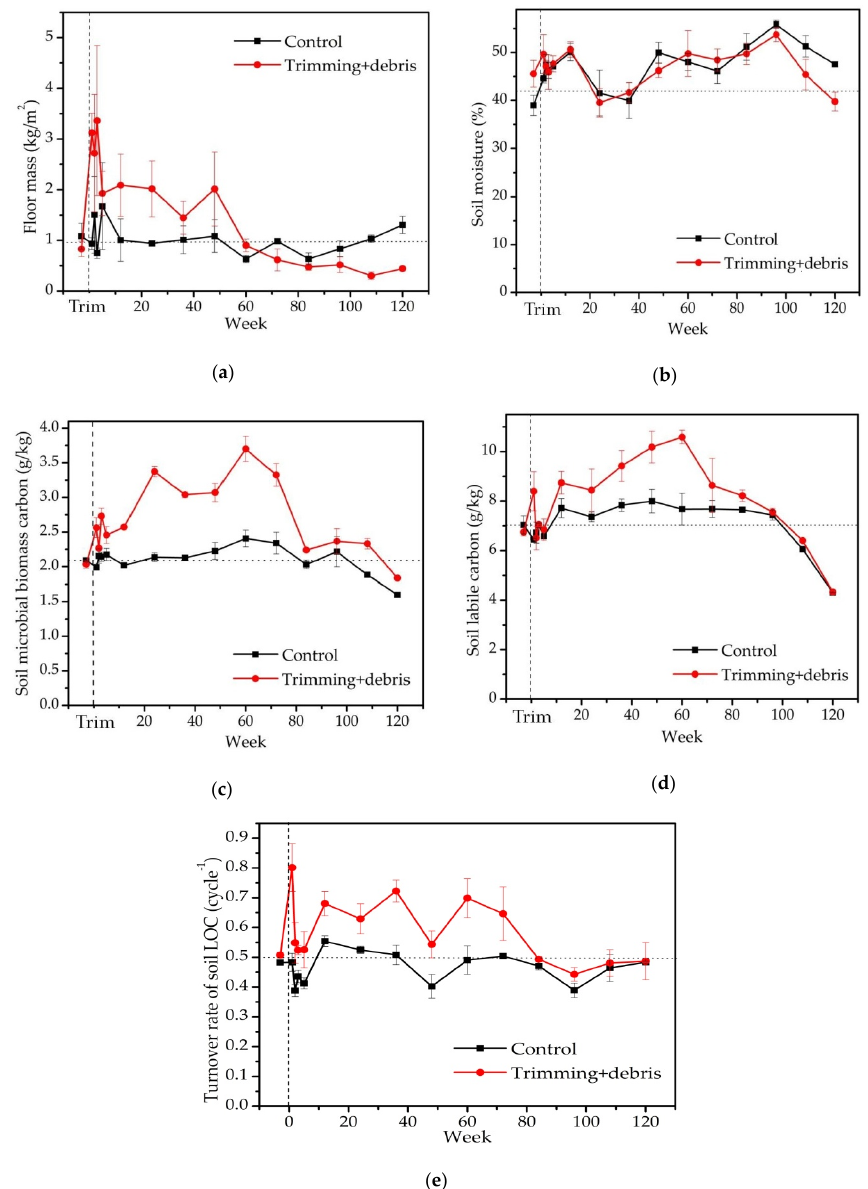
Figure 2. Dynamics of ( a ) floor mass, ( b ) soil moisture, ( c ) soil microbial biomass carbon (MBC), ( d ) soil labile organic carbon (LOC), and ( e ) turnover rate of soil LOC three weeks before and after the canopy trimming and debris deposition (CTDD) treatment for 120 weeks in the control and CTDD plots in the Luquillo Experimental Forest, Puerto Rico. Note: The week marked by the vertical dashed line was the week to trim forest canopy and deposit debris on the forest ground in the CTDD plots; the value marked by the horizontal dotted line was the corresponding value of floor mass, soil moisture, soil MBC, soil LOC, and the turnover rate of soil LOC measured in the control and CTDD plots three weeks before the CTDD treatment. Error bars represent the standard error.